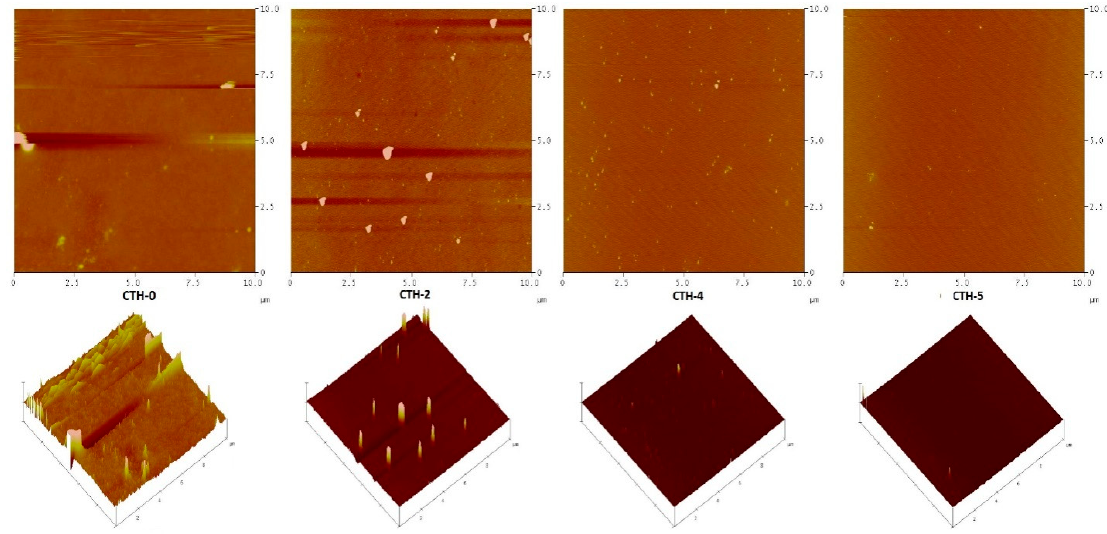
Figure 3. AFM images of films with different chitosan/PAH compositions—100/0 (CTH-0), 80/10 (CTH-2), 60/40 (CTH-4), and 40/60 (CTH-5)—and their corresponding 3D images in panels on mica using tapping mode. The scale size was 10 × 10 μ m and the z scale was 20 nm and 30 nm, respectively.